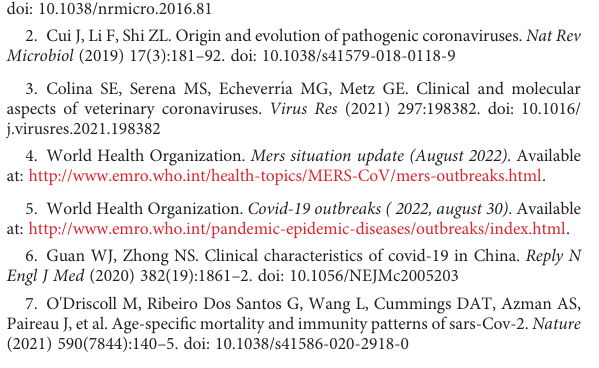
SUPPLEMENTARY FIGURE 1 Gating strategy for isolating MERS-CoV spike S2-speci fi c memory B cells from COVID-19 convalescents. PBMC of COVID-19 convalescents were fi rst stained with LIVE/DEAD and CD3/CD19 -speci fi c antibodies to exclude T cells and monocytes. Then, CD27/IgD/IgG antibodies were used to select mature B cells. Two probes MRES-CoV S2-AF488 and S2- AF647 were used to select MERS-CoV S2-speci fi c memory B cells. Single B cell position for S2 + /AF647 + and S2 + /AF488 + was sorted into 96-well plates for construction of mAbs.